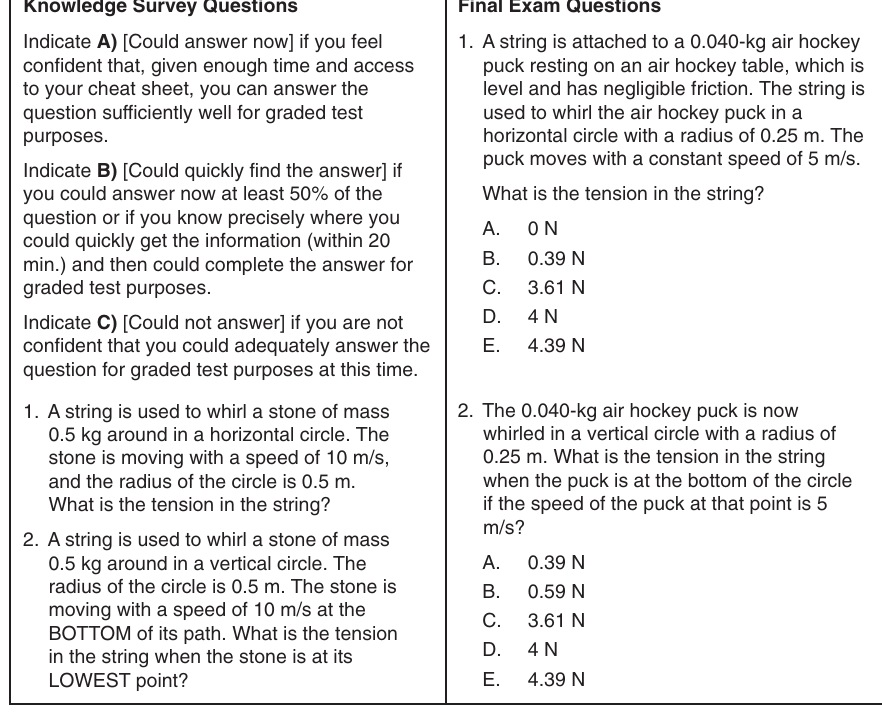
FIG. 1. A pair of questions from the physics KS, and the corresponding questions from the physics final